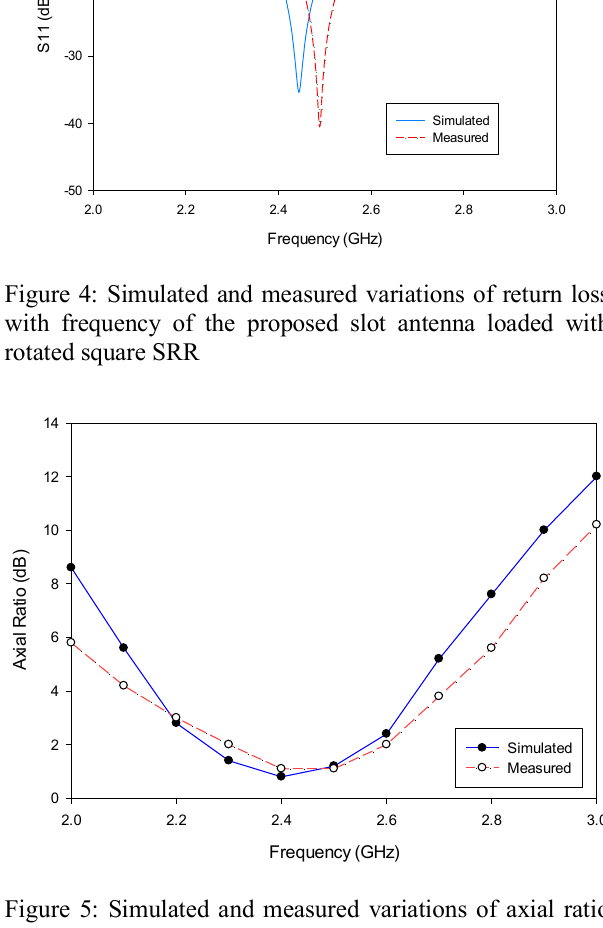
Figure 5: Simulated and measured variations of axial ratio with frequency for the proposed slot antenna loaded with rotated square SRR